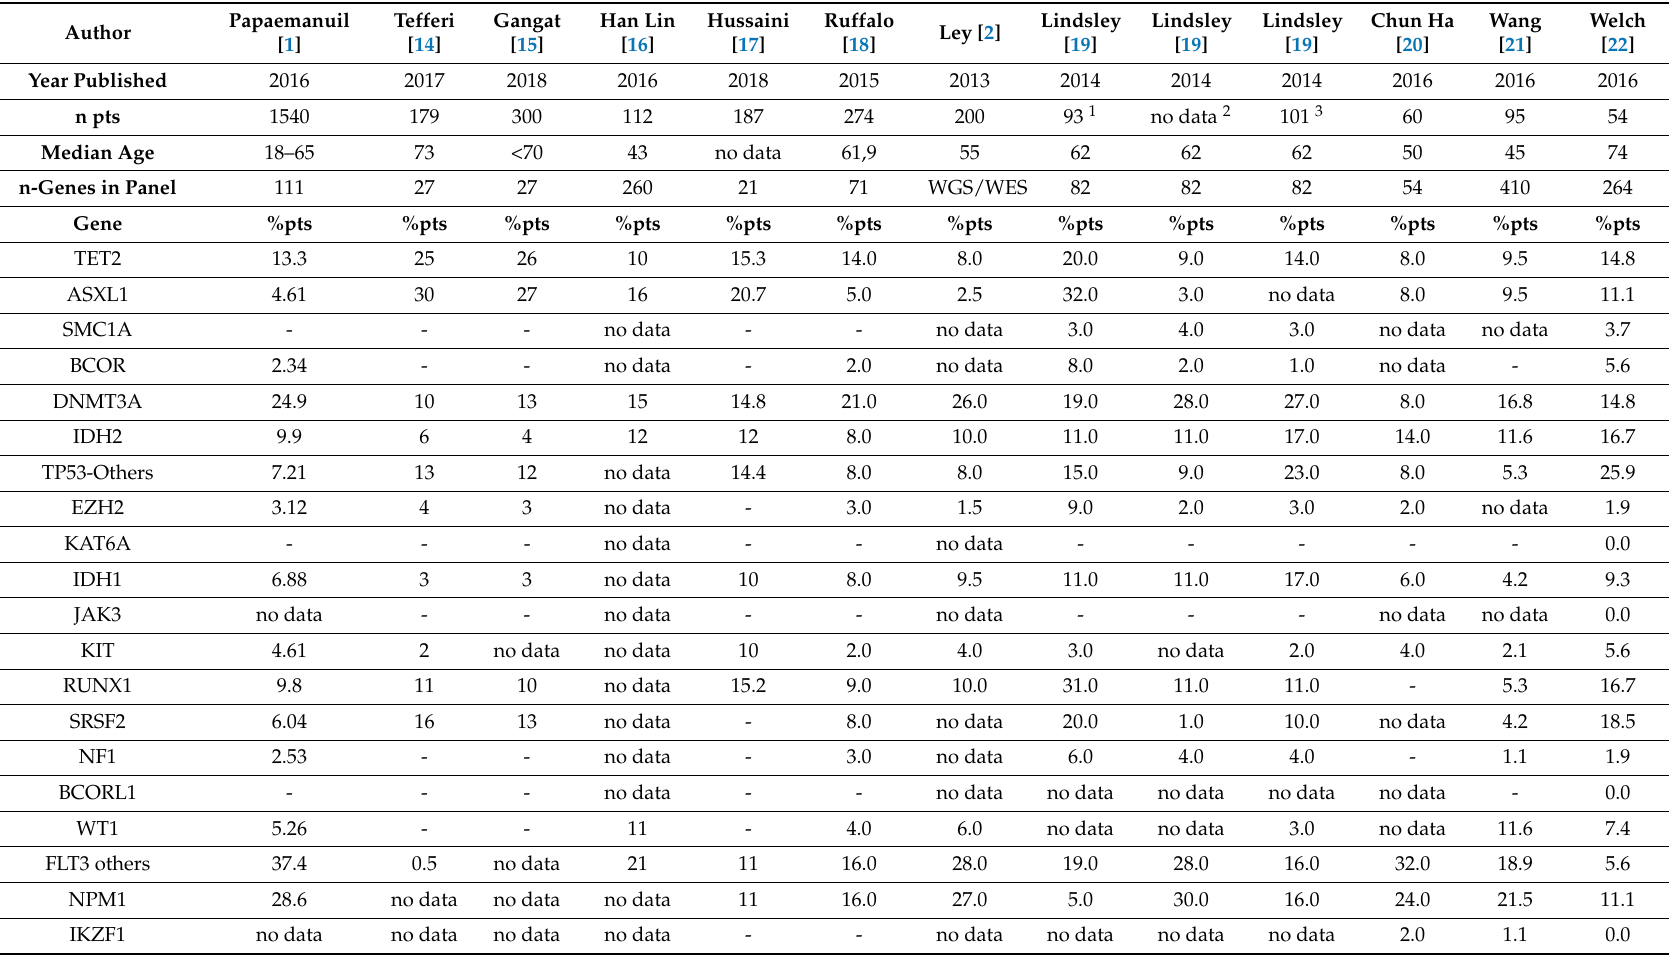
Table 2. Summary of analysed genes in major NGS based sequencing studies in AML ( n > 50